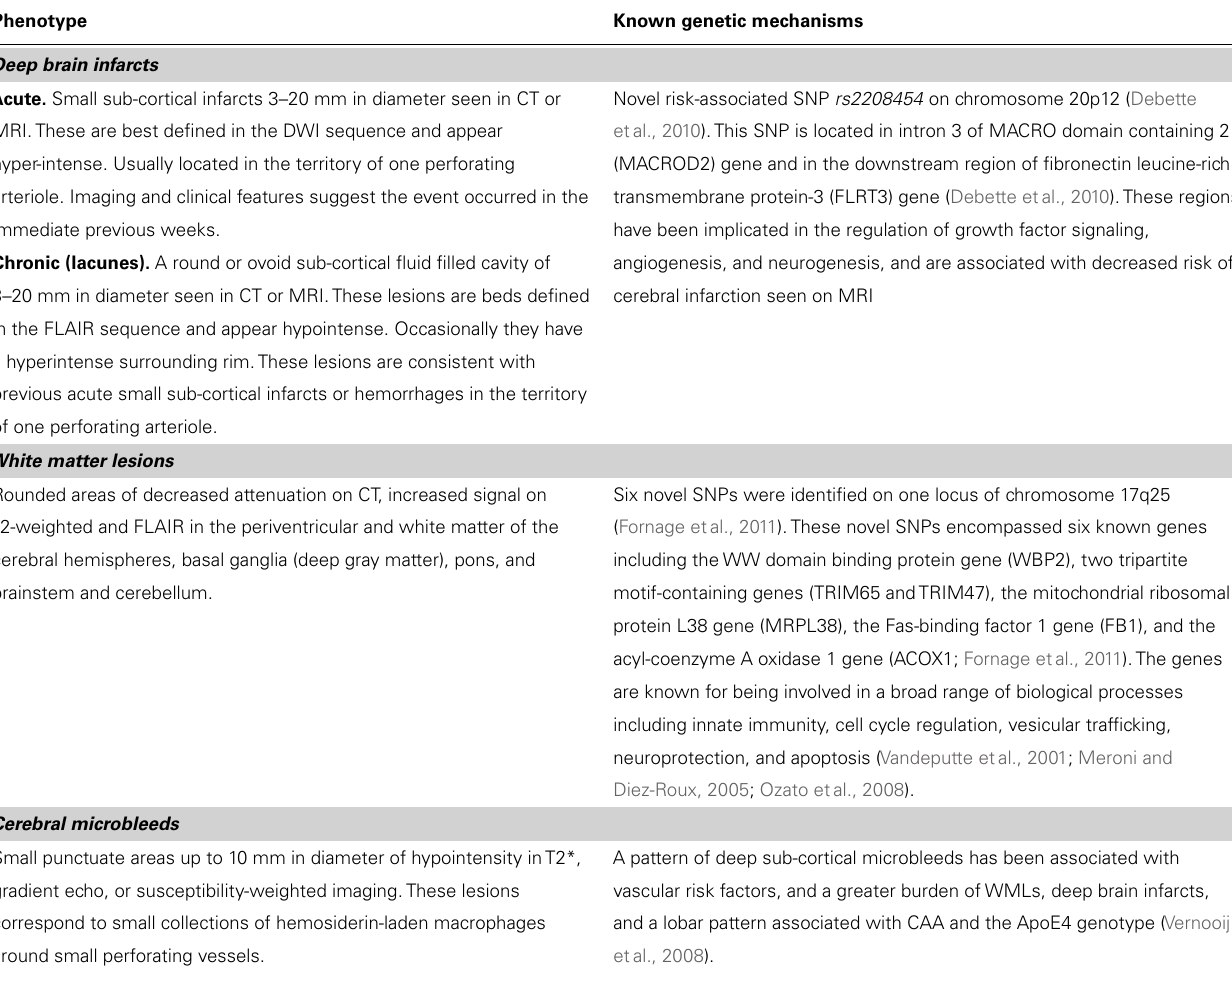
Table 1 | Glossary of definitions of SVD